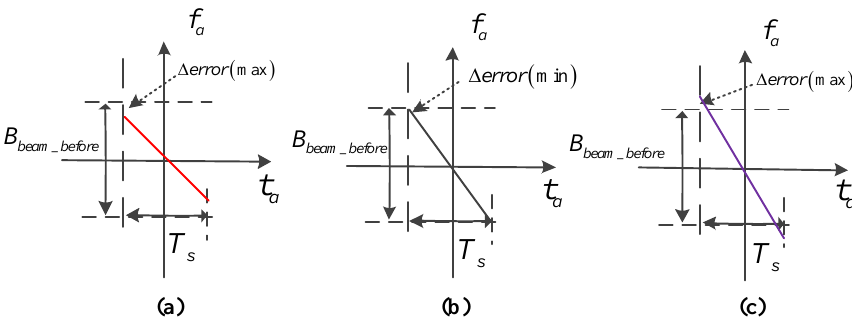
Figure 9. After dechirp processing the Doppler time-frequency relationship in the range frequency domain, which shows the error caused by the wideband signal without updating f r , the max error is caused by f r = ± B r /2. The red line shows the Doppler time-frequency relationship in ( a ) while f r = − B r /2. The purple line shows the Doppler time-frequency relationship in ( b ) while f r = B r /2. The black line shows the Doppler time-frequency relationship in ( c ) while f r = 0